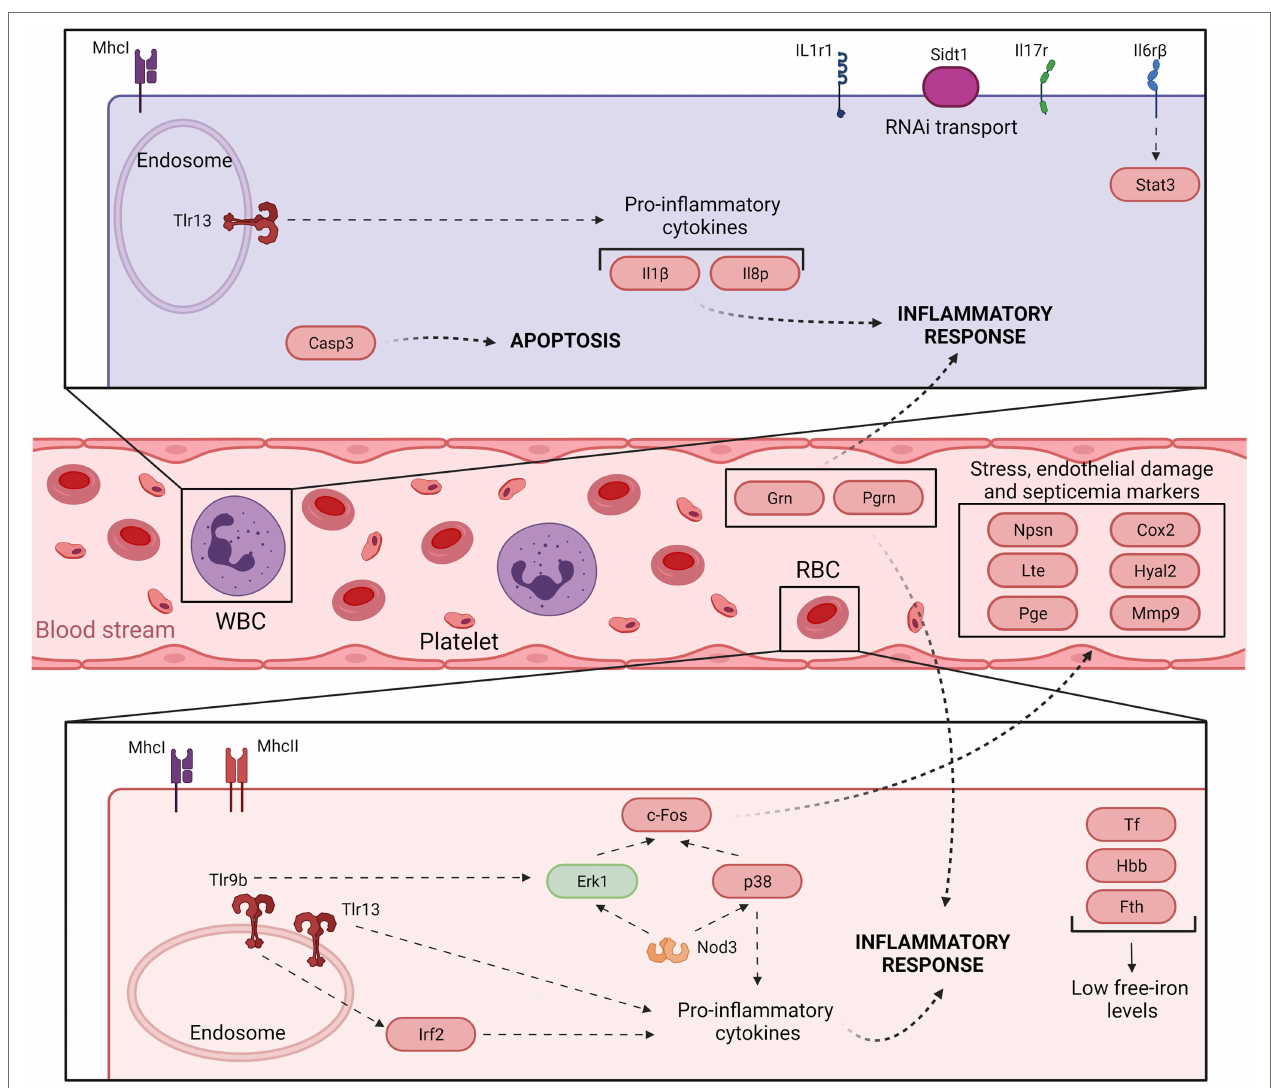
FIGURE 4 | Model of the immune response in eel blood against V. vulnificus infection: late phase of vibriosis (12 hpi). The model shows the resultant proteins produced by the main transcripts differentially expressed by eels’ blood cells during the late phase of Vv-vibriosis (at 12 hpi with V. vulnificus R99 strain) infection. The putative translated proteins from the major immune-related pathways are represented in a code color depending on the gene modulation: upregulated (red) and downregulated